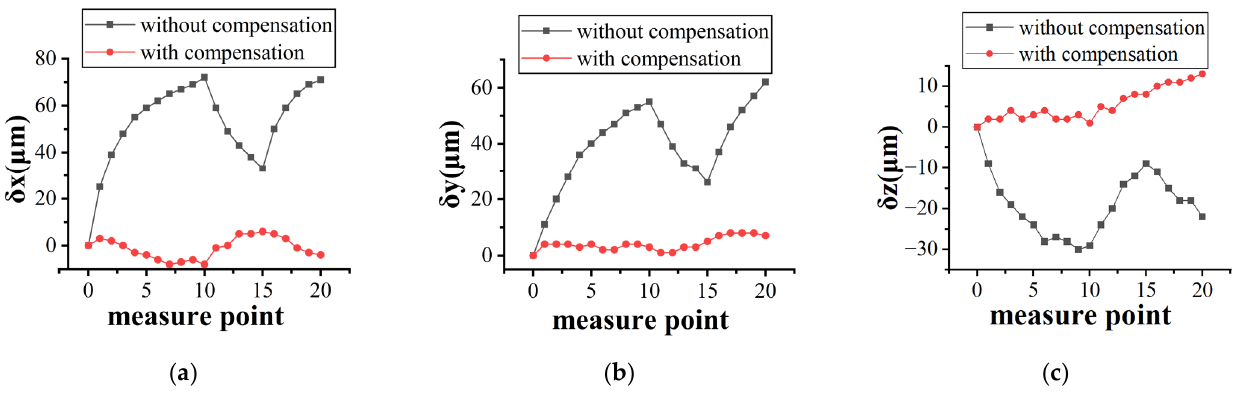
Figure 16. Test piece measurement results. ( a ) δ x. ( b ) δ y. ( c ) δ z.